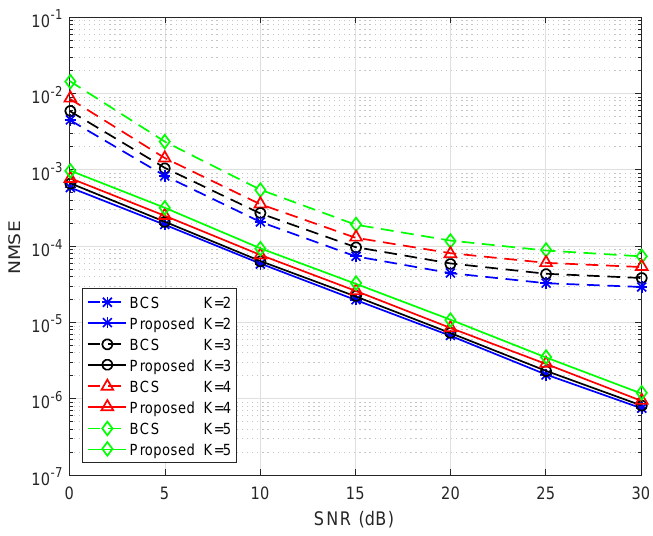
Figure 5. NMSE performance comparison of the proposed and BCS algorithms.